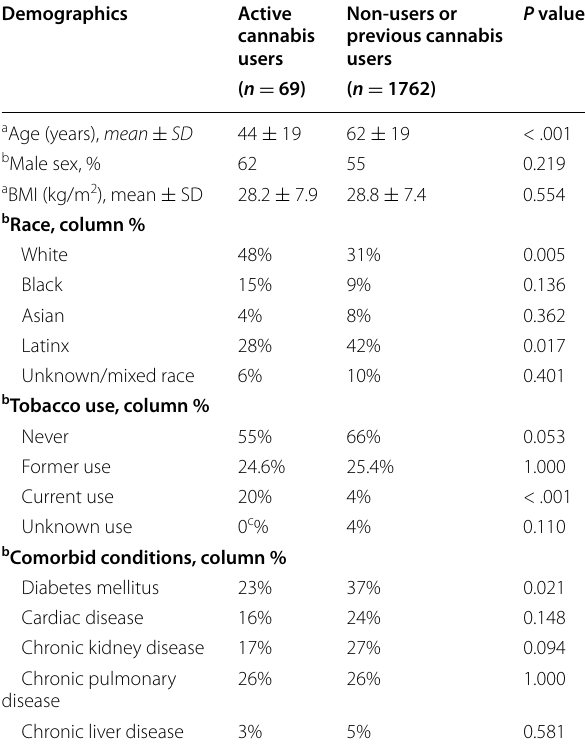
Table 1 Baseline patient characteristics comparing subjects who did and did not actively consume cannabis products